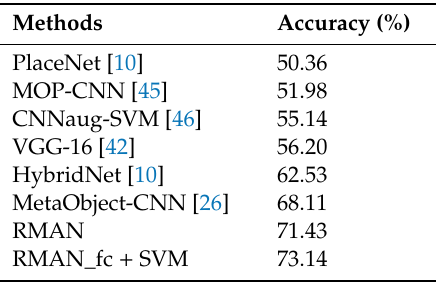
Table 3. Comparison of RMAN with other methods on